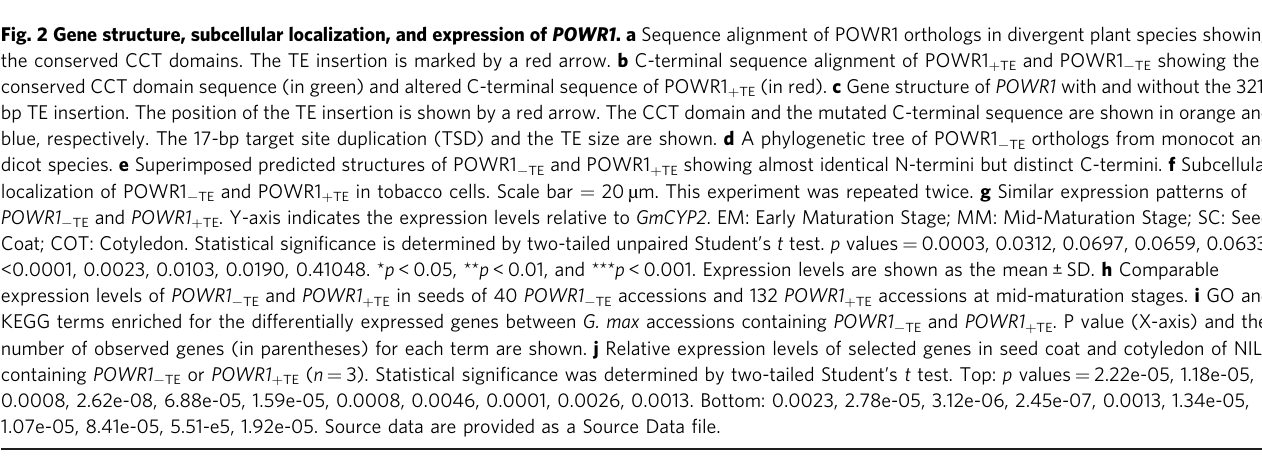
Fig. 2 Gene structure, subcellular localization, and expression of POWR1 . a Sequence alignment of POWR1 orthologs in divergent plant species showing the conserved CCT domains. The TE insertion is marked by a red arrow. b C-terminal sequence alignment of POWR1 + TE and POWR1 − TE showing the conserved CCT domain sequence (in green) and altered C-terminal sequence of POWR1 + TE (in red). c Gene structure of POWR1 with and without the 321- bp TE insertion. The position of the TE insertion is shown by a red arrow. The CCT domain and the mutated C-terminal sequence are shown in orange and blue, respectively. The 17-bp target site duplication (TSD) and the TE size are shown. d A phylogenetic tree of POWR1 − TE orthologs from monocot and dicot species. e Superimposed predicted structures of POWR1 − TE and POWR1 + TE showing almost identical N-termini but distinct C-termini. f Subcellular localization of POWR1 − TE and POWR1 + TE in tobacco cells. Scale bar = 20 µ m. This experiment was repeated twice. g Similar expression patterns of POWR1 + GmCYP2 . EM: Early Maturation Stage; MM: Mid-Maturation Stage; SC: Seed POWR1 − TE and TE . Y-axis indicates the expression levels relative to Coat; COT: Cotyledon. Statistical signi fi cance is determined by two-tailed unpaired Student ’ s t test. p values = 0.0003, 0.0312, 0.0697, 0.0659, 0.0633, <0.0001, 0.0023, 0.0103, 0.0190, 0.41048. * p < 0.05, ** p < 0.01, and *** p < 0.001. Expression levels are shown as the mean ± SD. h